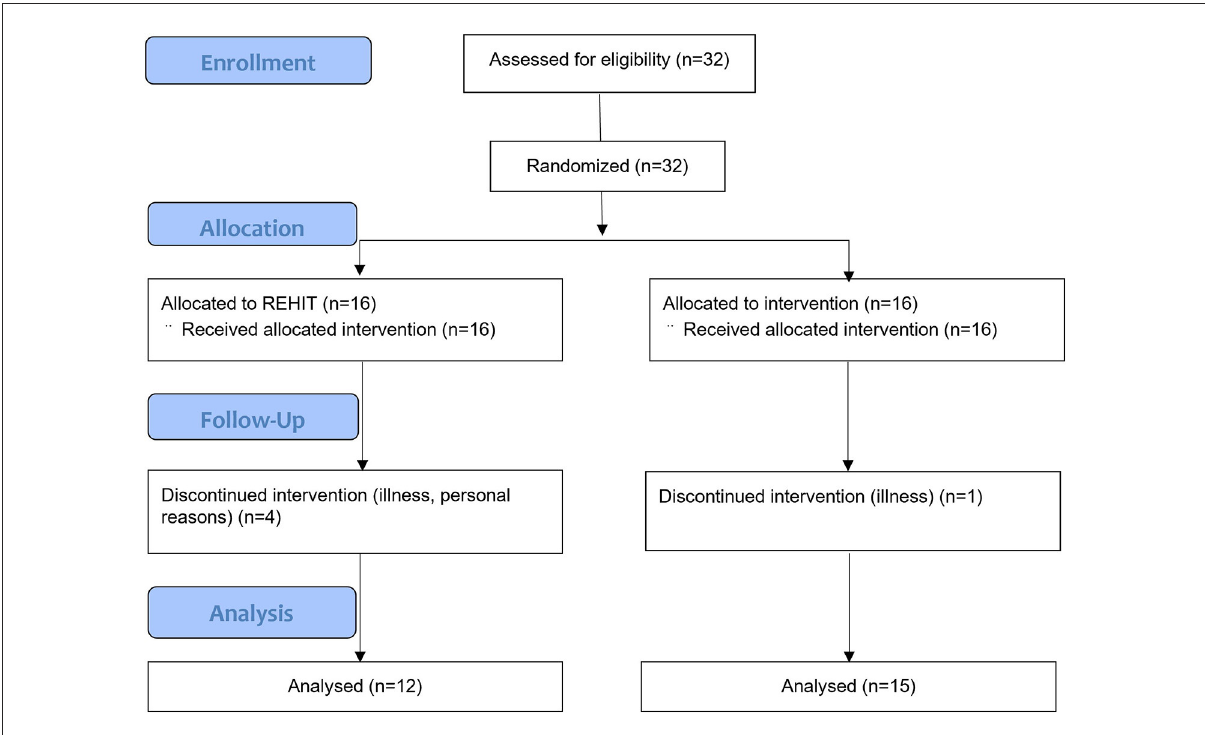
FIGURE1 Consort flow diagram for FFI